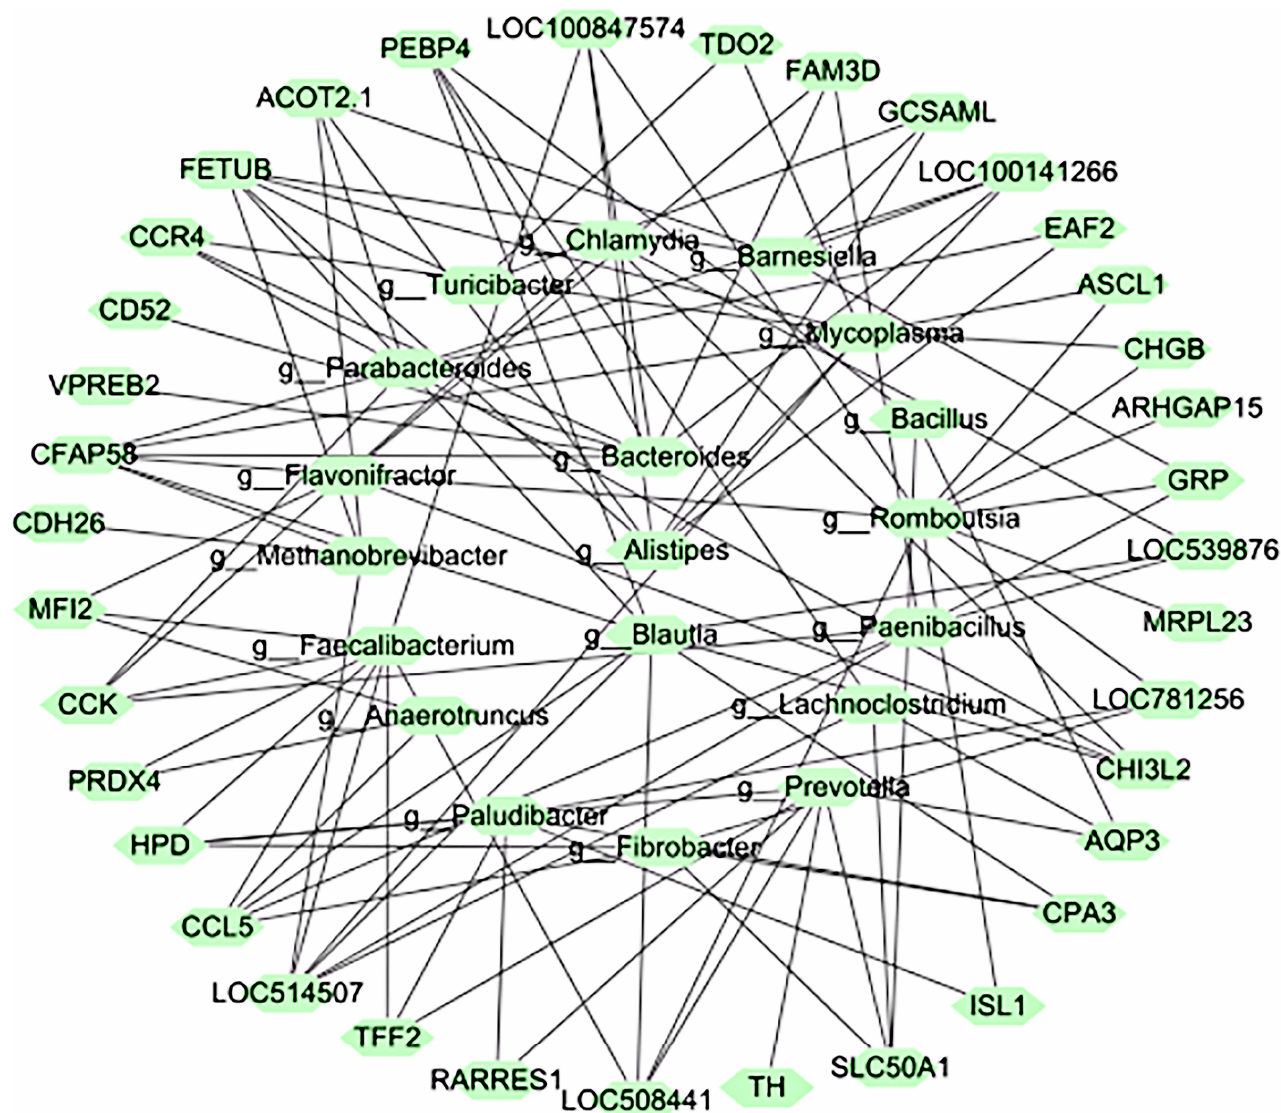
Figure 5. Network diagram of microbe-gene relationships with significant correlation.